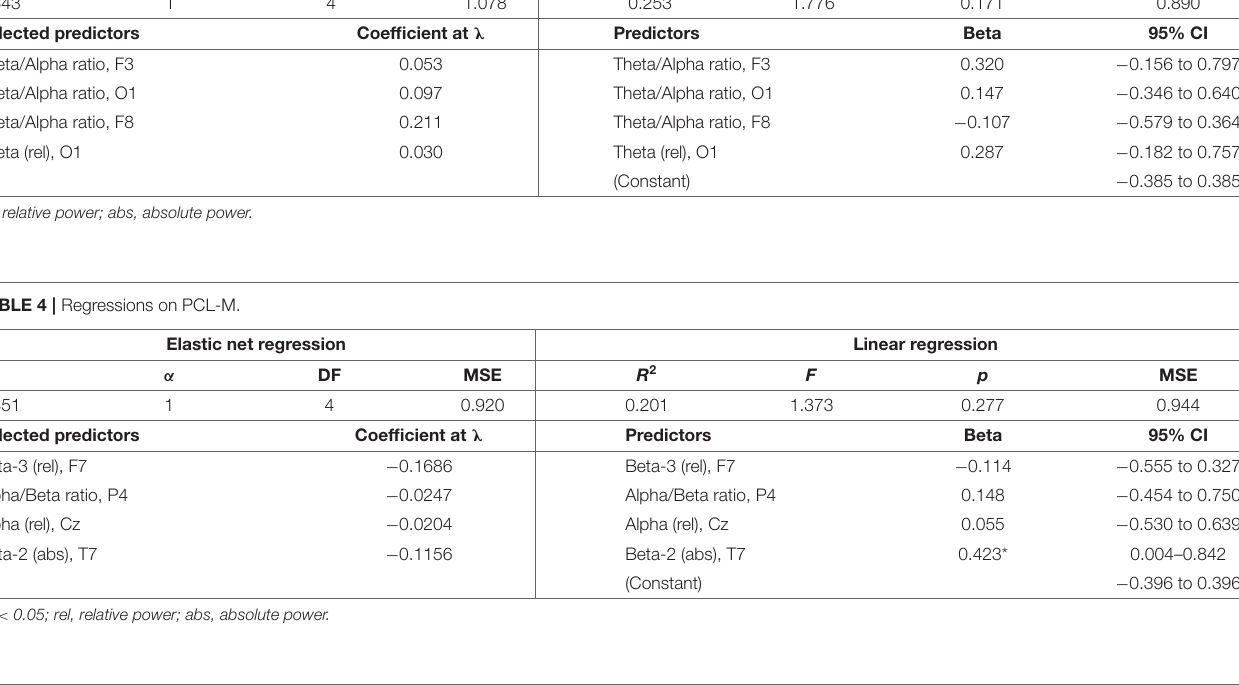
TABLE 5 | Regressions on NSI